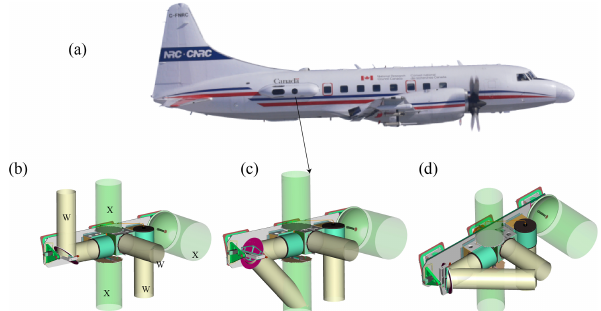
Figure 2. (a) The NRC airborne W- and X-band (NAWX) radar in- stallation inside the starboard blister radome mounted on the Con- vair 580. The aft antenna beam can be redirected from nadir and up to 50 ◦ forward along the flight direction. The aft antenna beam redirected (b) to the zenith direction using a reflector, (c) to the nadir-forward and (d) to the side-forward